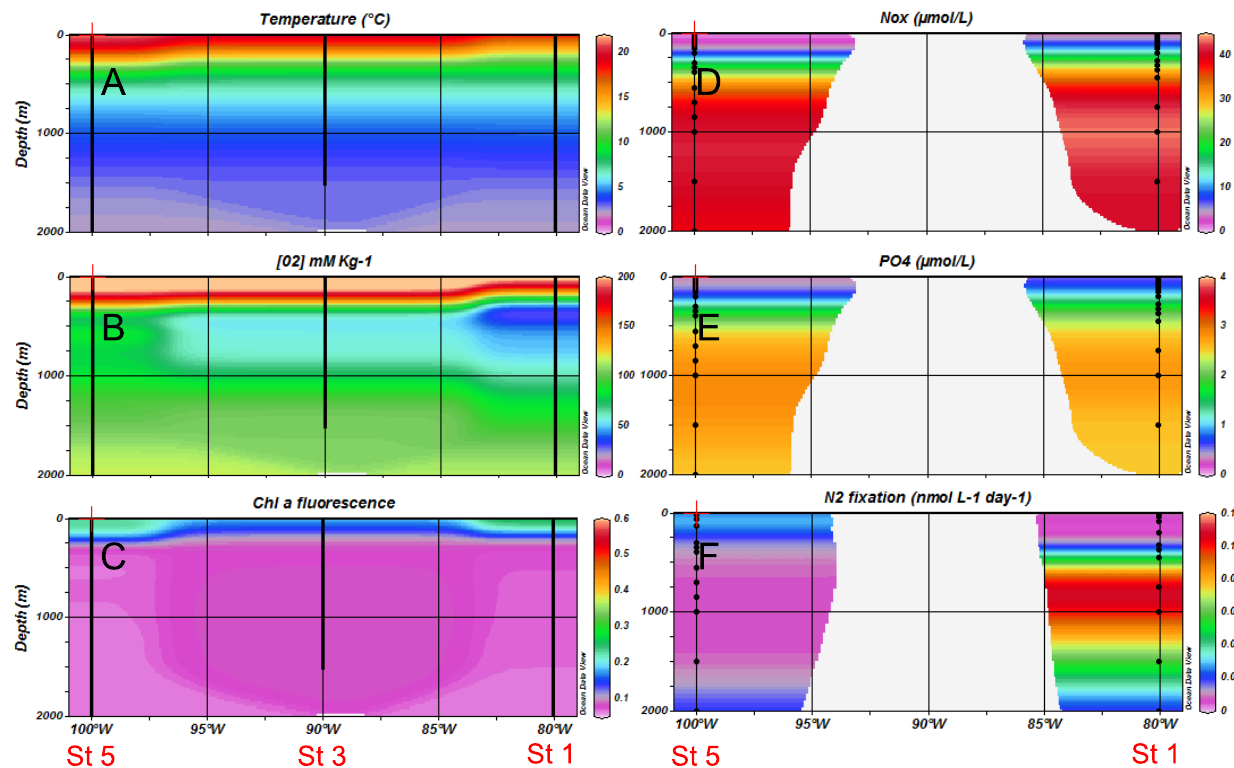
Figure 4. Horizontal and vertical distributions of hydrological and biogeochemical parameters during the 2011 cruise (R/V Melville) – Southern transect (20 6 S). (A) temperature, (B) dissolved oxygen, (C) chlorophyll a fluorescence, (D) NO 3 2 concentrations, (E) PO 43 2 concentrations, (F) Mean N 2 fixation rates (n=3).